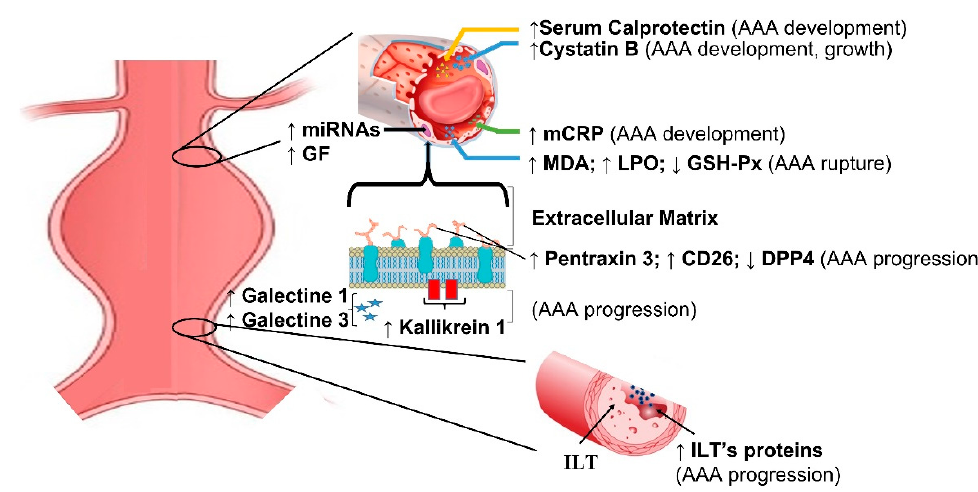
Figure 2. Schematic representation of main biomarkers in abdominal aortic aneurysms. mCRP = monomeric form of C-reactive protein; MDA = malondialdehyde; LPO = lipid hydroperoxide; GSH- Px = glutathione peroxidase; DPP4 = dipeptidyl peptidase–4; ILT = intraluminal thrombus; ILT’s proteins = intraluminal thrombus proteins; miRNAs = micro RNA; GF = genetic factors.